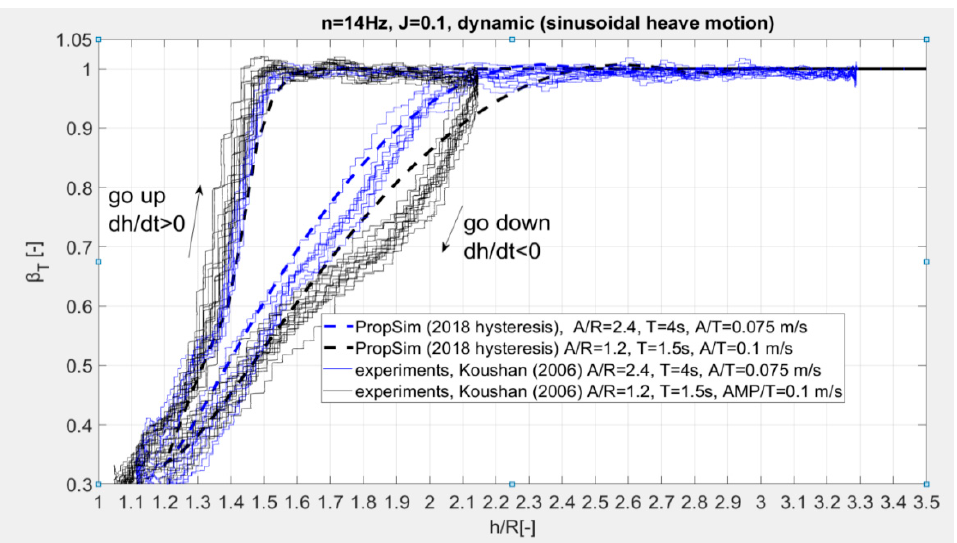
Figure 8. Comparison for thrust loss between experiments (dynamic) and simulation (PropSim2018_hysteresis) for different amplitudes of the propeller (heave), see Case 4 and 5 presented in Table 2; the simulation includes the hysteresis effect for two different motions of the propeller (upwards and downwards), PropSim2018_hysteresis, the blue line for the up behavior is similar and lies under the black line.